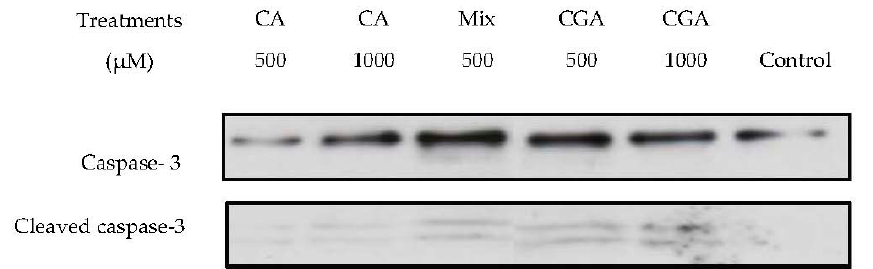
Figure 5. Effect of CGA, CA and MIX treatment for 24 h on cleaved and uncleaved caspase-3 levels as evaluated by Western blotting. CGA = chlorogenic acid; CA = caffeic acid; MIX = equimolar mixture of the four tested compounds.